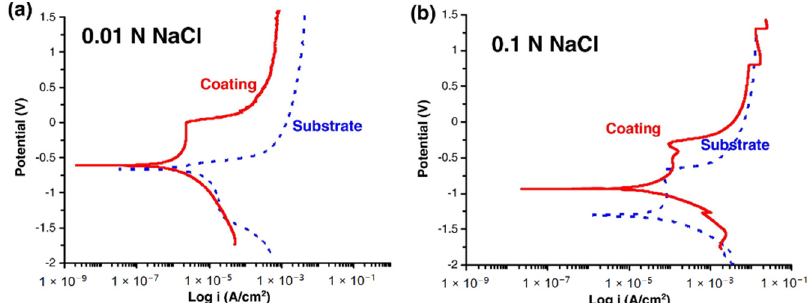
Figure 4. ( a ) Wear volume vs. time plot with respective SPM (Scanning Probe Microscope) images for tracks at 60 min, ( b ) profile of the track across the width after 60 min, ( c ) coefficient of friction vs. time plot for Al-BMG (Al-bulk metallic glass) coatings and Al-6061 substrate. Reprinted with permission from [53] Copyright 2021 Elsevier.